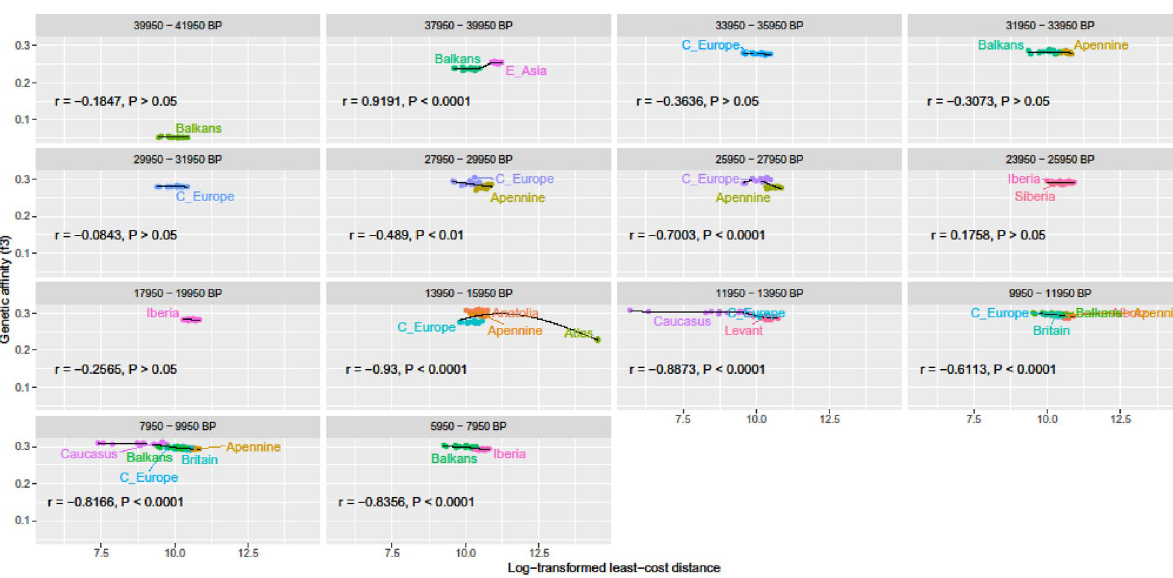
Figure 3. Genetic affinity (f3) between modern populations of the Caucasus and ancient populations (labeled in different colors), plotted against least-cost distance for different 2000-year-long periods before present (BP). Pearson correlation coefficients (r) show relationships between f3 and linear least-cost distance. The smoothing lines are applied using the GAM-REML